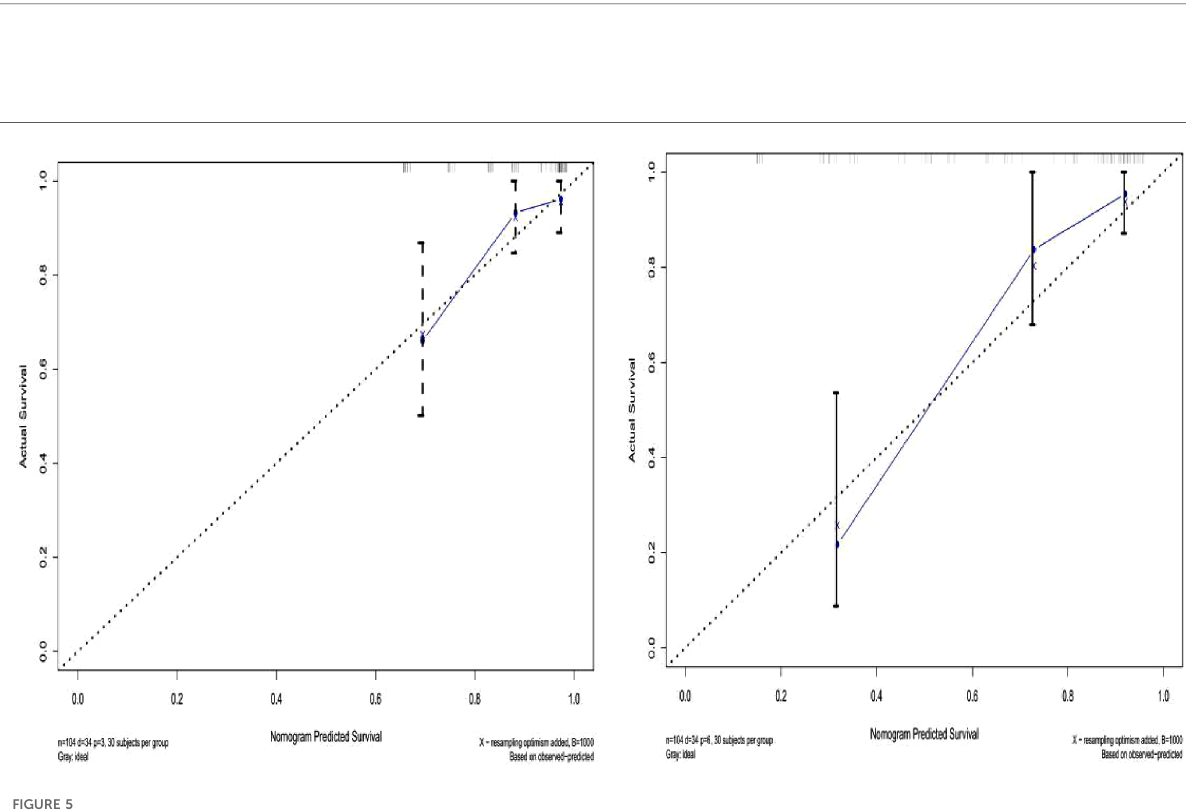
FIGURE 5 Validation set survival calibration curve for patients with hepatic alveolar